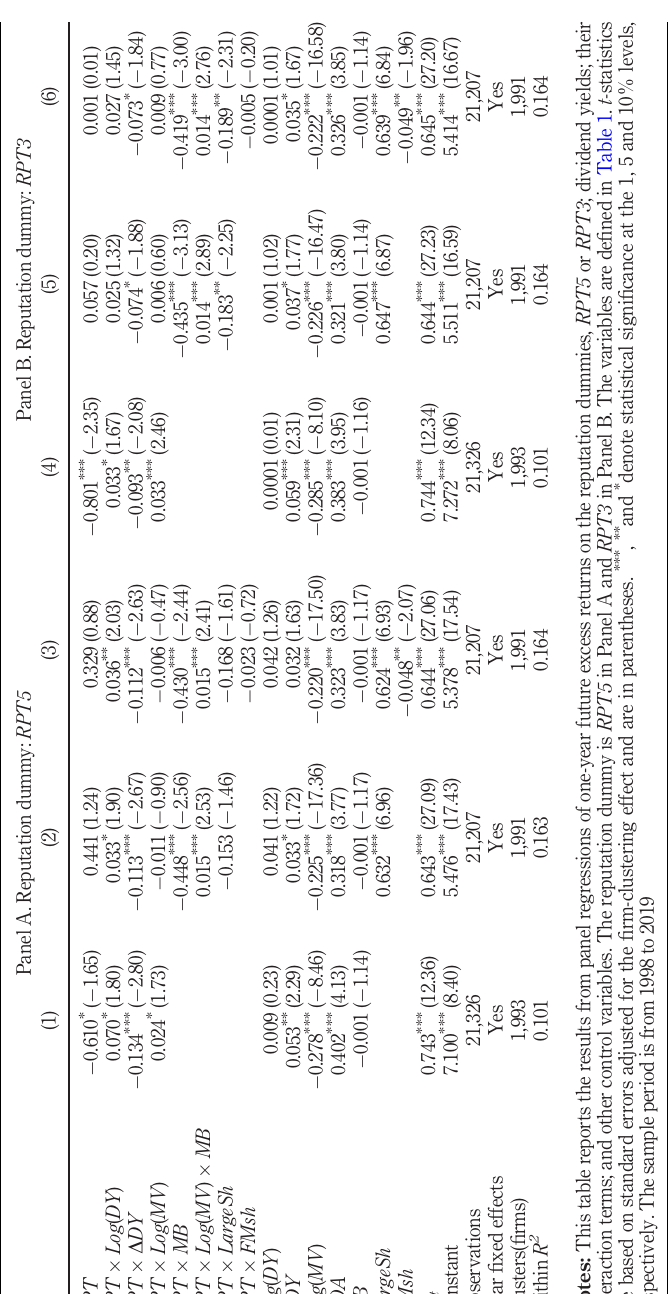
Table 11. Relation between reputation, stock returns and dividend